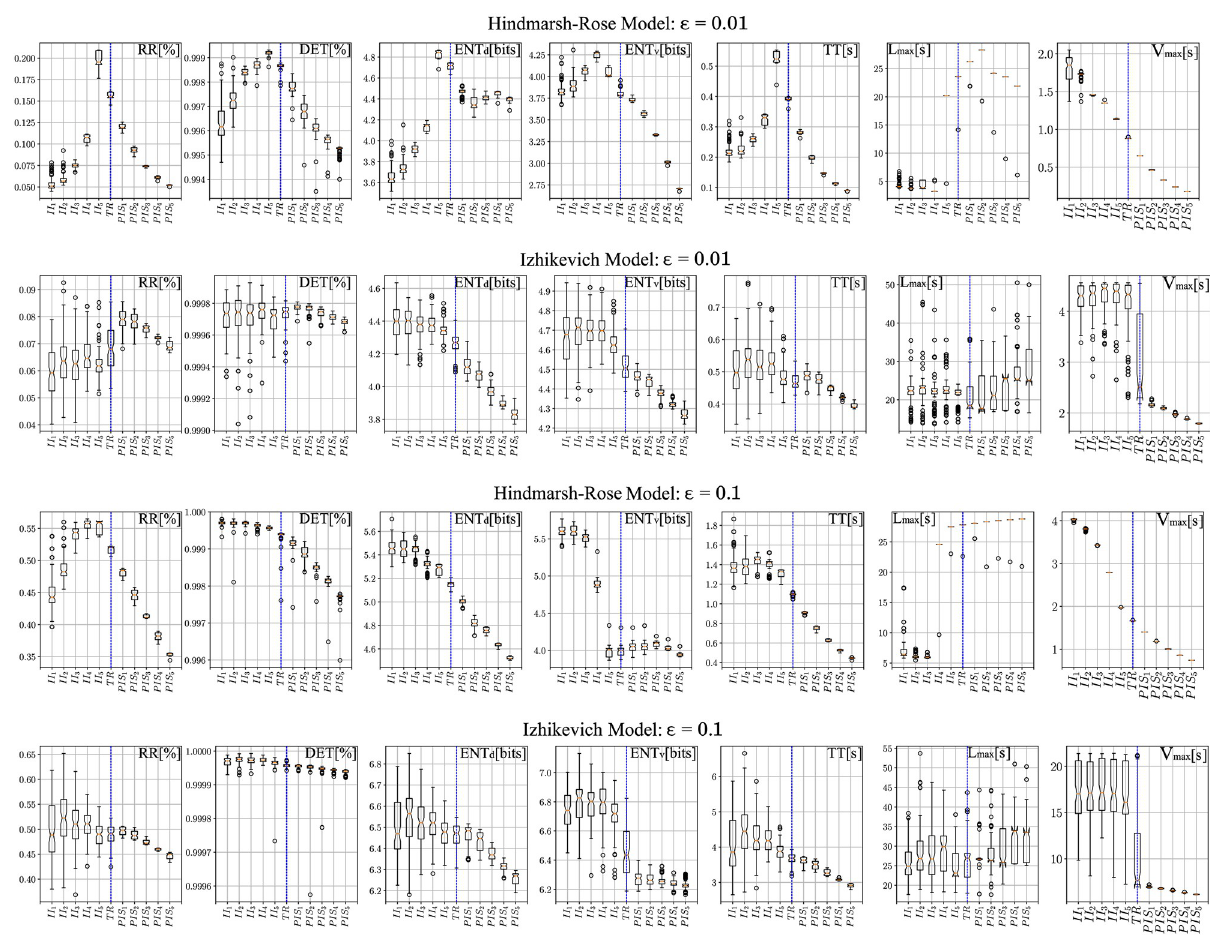
Fig 9. Effect of threshold on the RQA parameters considering the Hindmarsh-Rose and Izhikevich models. Box plots for the six parameters studied in this work are presented (an exception is the vertical entropy ENTv, which is a complementary result) for the 11 cases and 2 different threshold values ( � = 0.01, 0.1): 5 for interictal activity (II), 1 transition (TR) and 5 for the ictal activity (PIS). Vertical blue dashed lines indicate a visual separation between the chaotic and regular spiking.